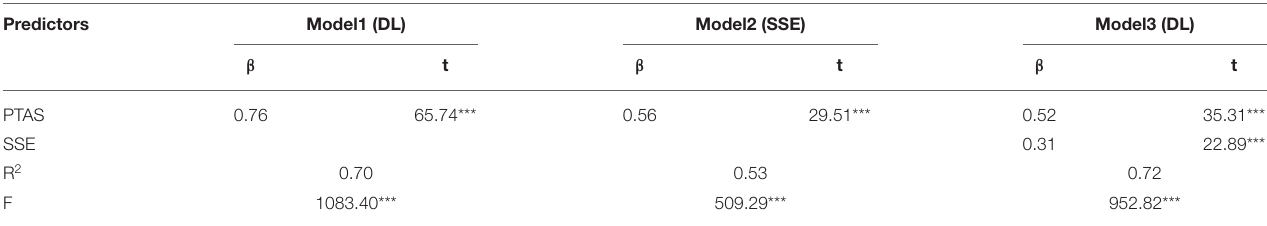
TABLE 2 | Testing the mediation effect of perceived teacher autonomy support and students’ deep learning. Predictors